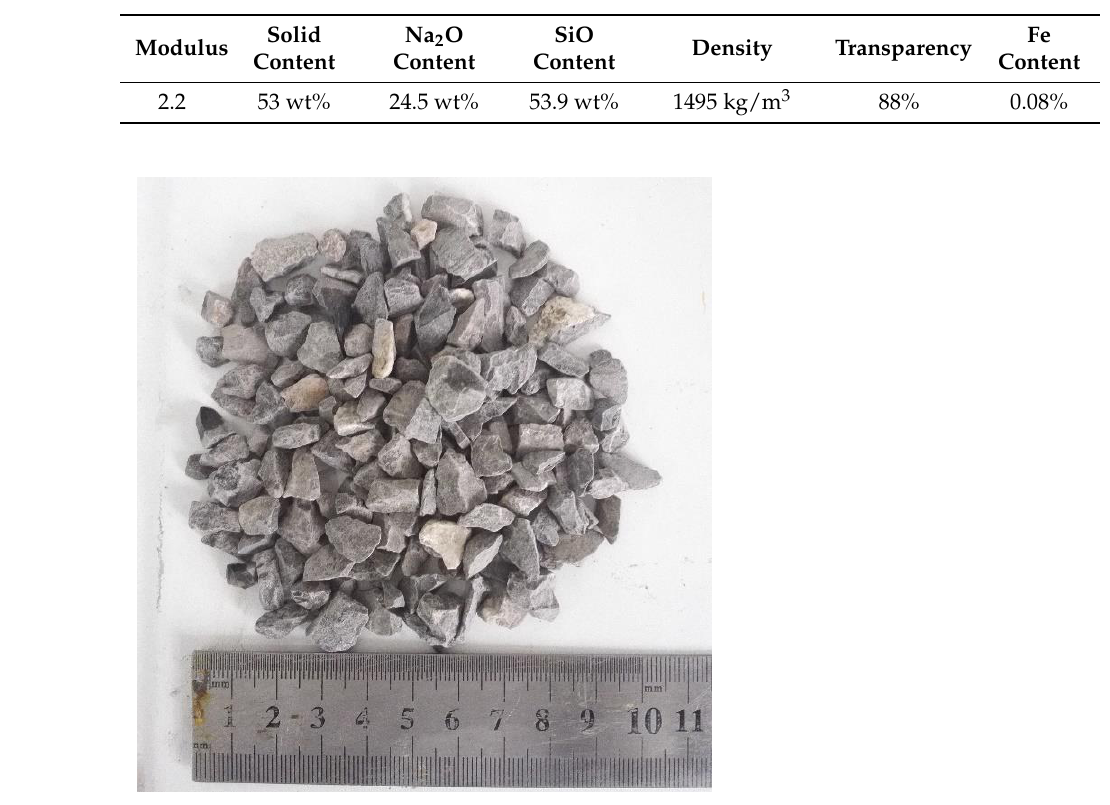
Table 2. Chemical and physical properties of water glass.